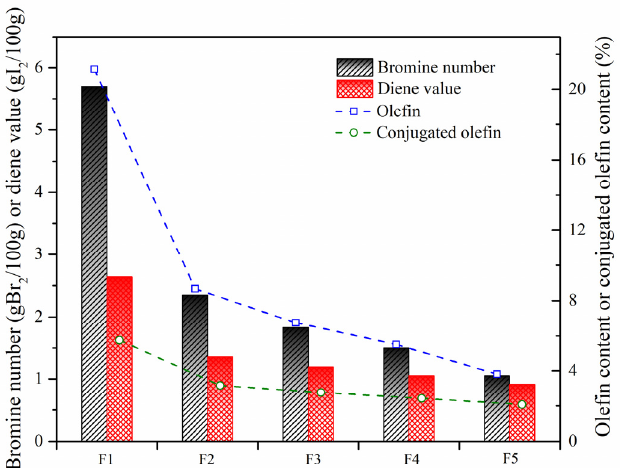
Figure 10. Bromine numbers and diene values of SLO before and after hydrogenation. The feed FCC slurry oil is designated as F1; FCC after reaction with non-catalyst is designated as F2. FCC after reaction with A-MoS 2 is designated as F3; FCC after reaction with M-MoS 2 is designated as F4; FCC after reaction with Mo 2 C is designated as F5.